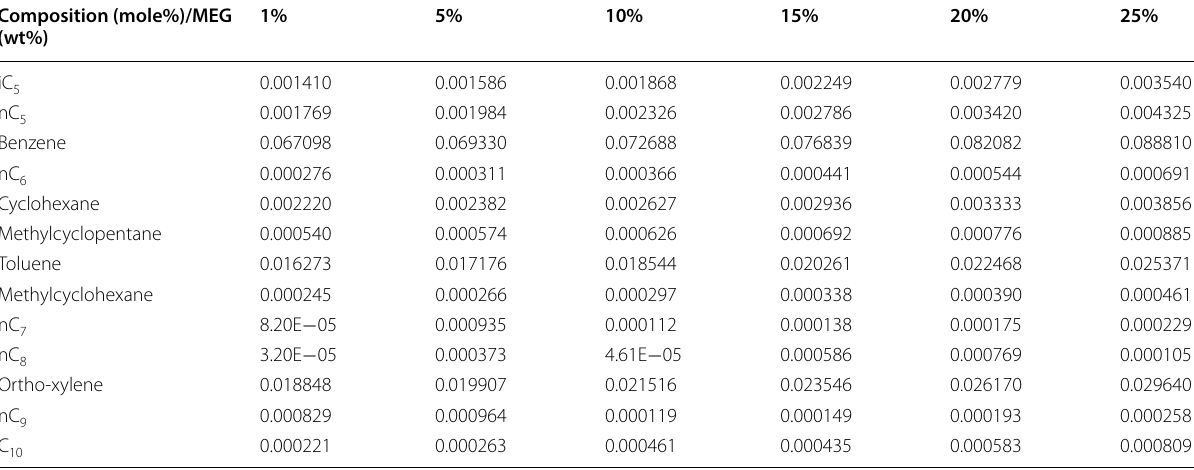
Table 5 Composition of acid gas routed to the SRU with lean amine solution containing 1, 5, 10, 15, 20, and 25 wt% MEG